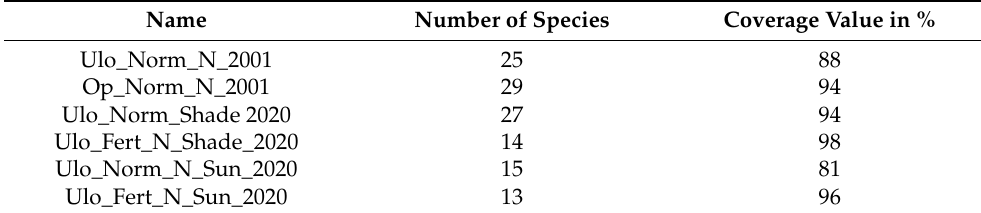
Table 3. Changes in the number of species from 2001 to 2020, 10-cm media.